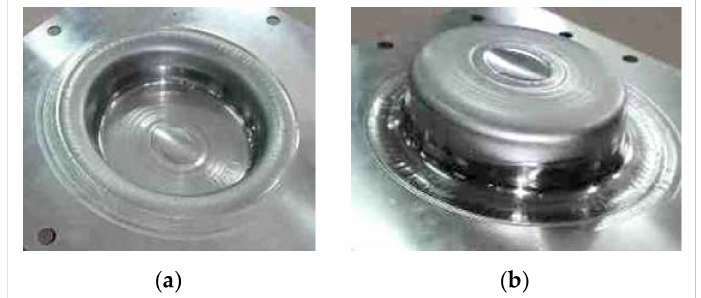
Figure 31. The experimental part: ( a ) the forward view ( b ) the reverse view.